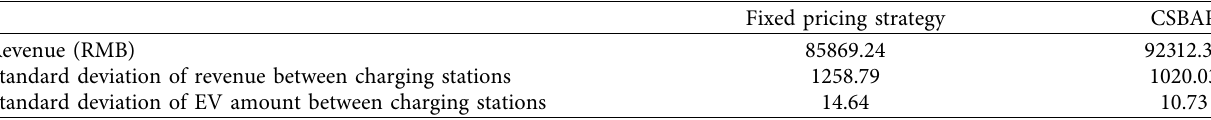
Table 10: Comparison between fixed pricing strategy and CSBAP.